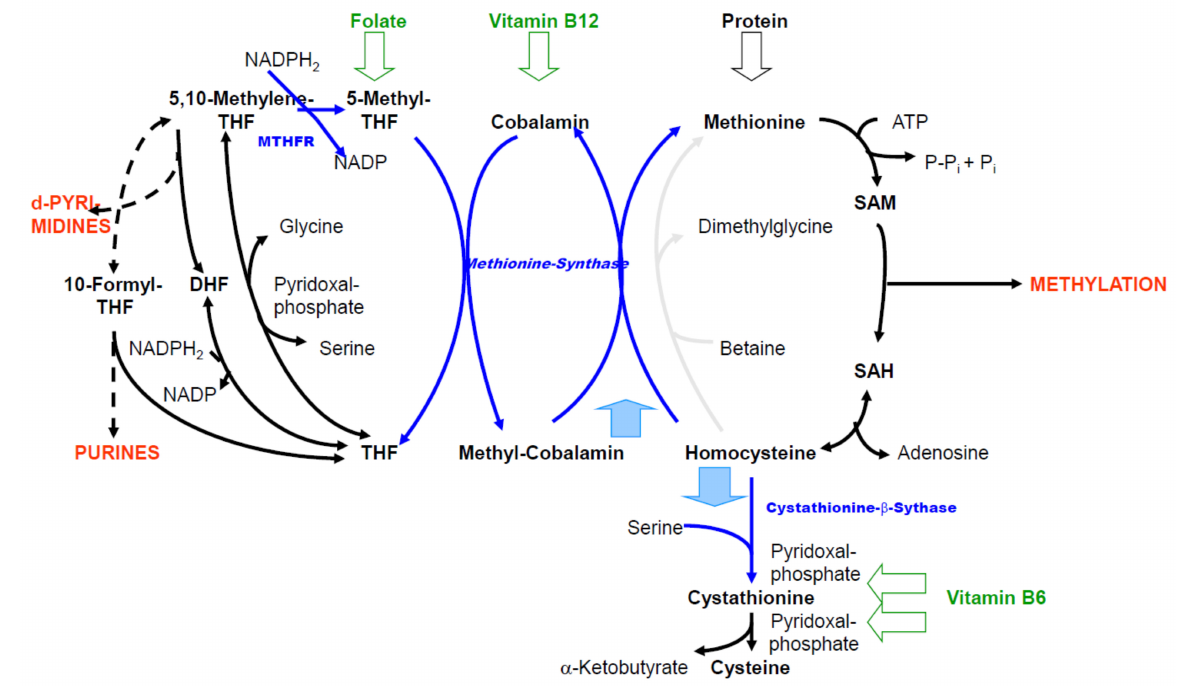
Figure 1. All essential reactions of the C1 metabolism: On the left side, the folic acid cycle is depicted, showing formyl and methenyl groups bound to tetrahydrofolate (THF), which is involved in purine synthesis (DNA, RNA), and methylene, involved in deoxythymidylate synthesis (DNA) and methyl groups that are required for the re-methylation of homocysteine (HCys) to methionine. On the right side, the methylation cycle is illustrated, including S-adenosylmethionine (SAM) methylations: nucleic acids, proteins, phospholipids, neurotransmitters, hormones, creatine and others. Histone protein, DNA and RNA methylations cause epigenetic regulation [1,2]. The vast majority of methylations originate from SAM [3]. More than 200 SAM-dependent methyltransferases are encoded in the human genome [4]. Red: products, intermediate reactions are omitted (dashed arrows); blue: reactions with enzymes for which genetic defects frequently occur or which catalyze reactions that can be reduced; green: necessary B-vitamins that cannot replace each other. The reaction catalyzed by methionine synthase needs two vitamins as cofactors at the same time; two light blue arrows: re-methylation of HCys (upwards), transsulfuration of HCys (downwards); MTHFR: 5,10-methylene tetrahydrofolate reductase,